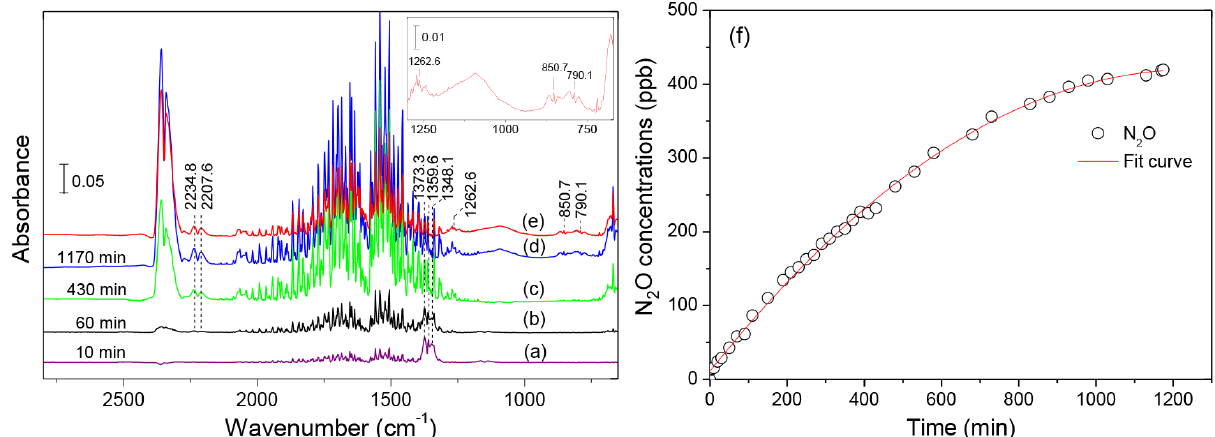
Figure 5. In situ FTIR spectra of FN-90 recorded upon exposure to 12.5ppm SO 2 + 21% O 2 at room temperature for different times. Left panel: (a) 10min; (b) 60min; (c) 430min; (d) 1170min; and (e) difference spectrum: (d) minus (c) . Right panel: (f) the concentration of the formed N 2 O as a function of time during the reaction of FN-90 sample with SO 2